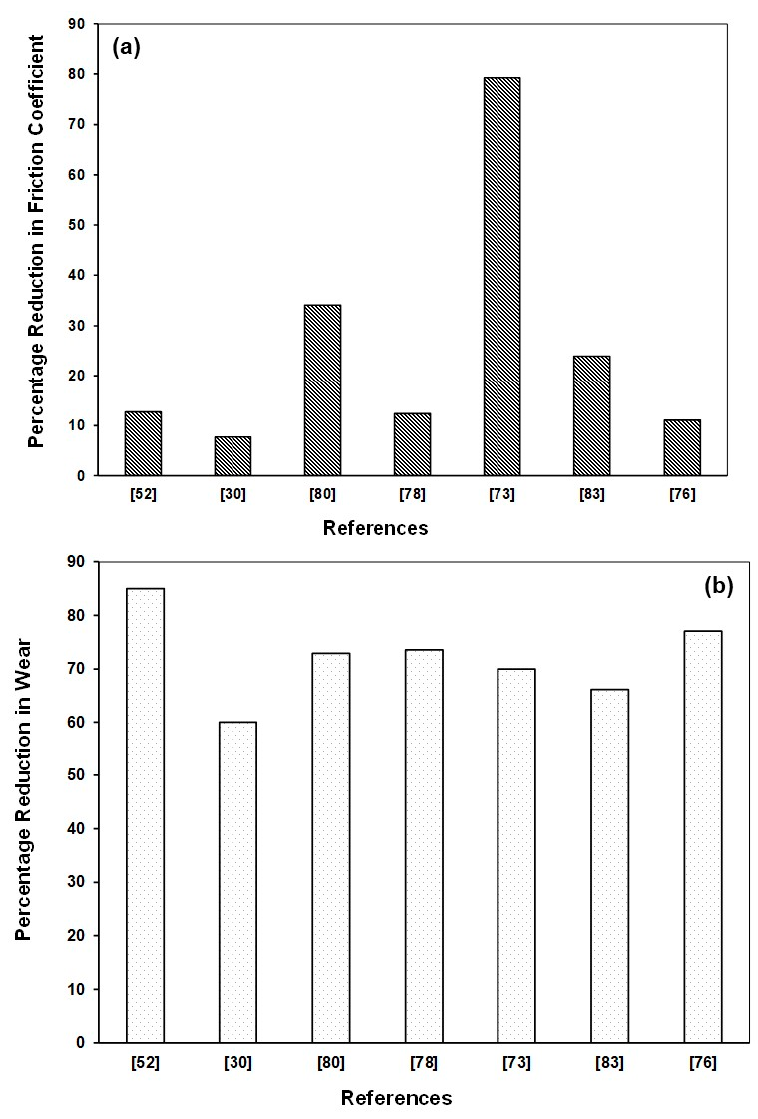
Figure 4. Comparison of effectiveness of LBE non-hybrid coatings in reducing ( a ) friction coefficient, ( b ) wear rate, under dry sliding conditions.